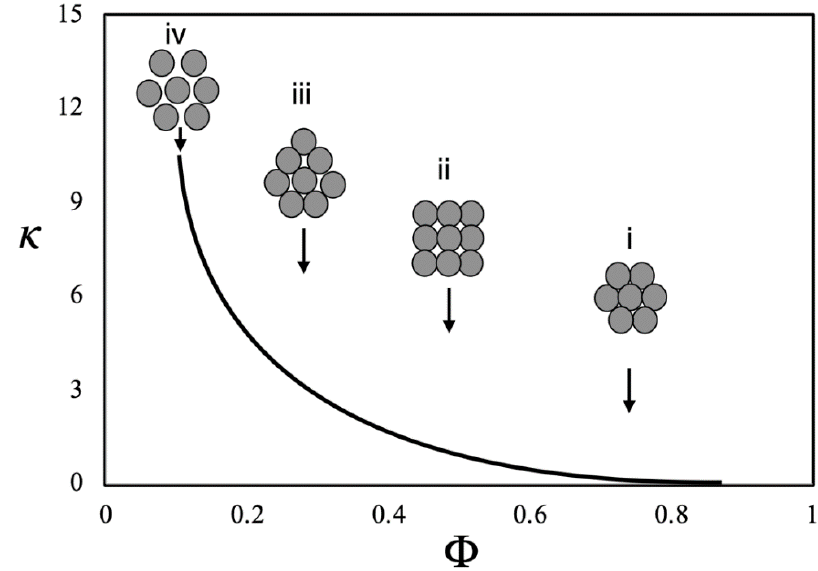
Figure 15. Scheme adapted of diagram proposed by (Eastman et al. [100]) to explain excess thermal conductivity enhancement in NFs. Where κ is the thermal conductivity as a function of the packing fraction of the cluster Φ (ratio of the volume of the solid particles in the cluster to the total effective volume of the cluster).